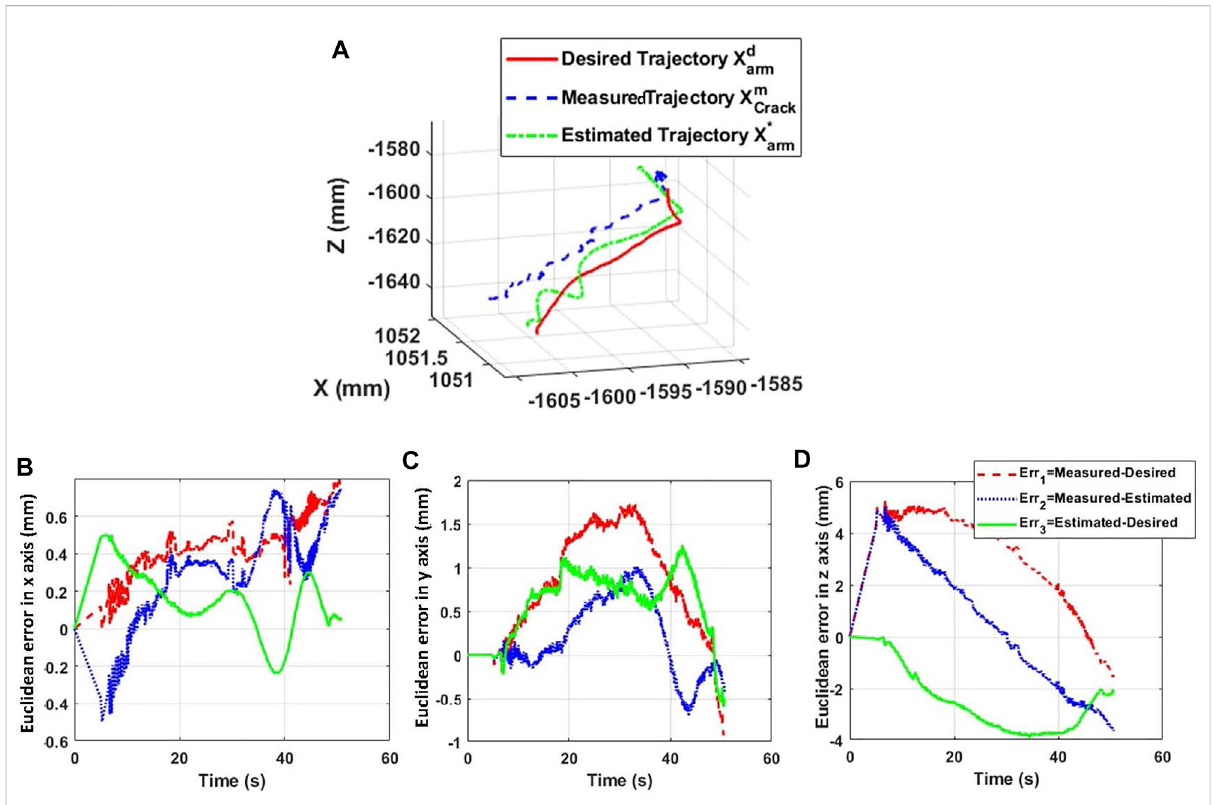
FIGURE 14 Trajectory of the tip of the arm during the reparation process of crack 1. (A) 3D position tracking of crack 1. (B) X -axis error. (C) Y -axis error. (D) Z -axis